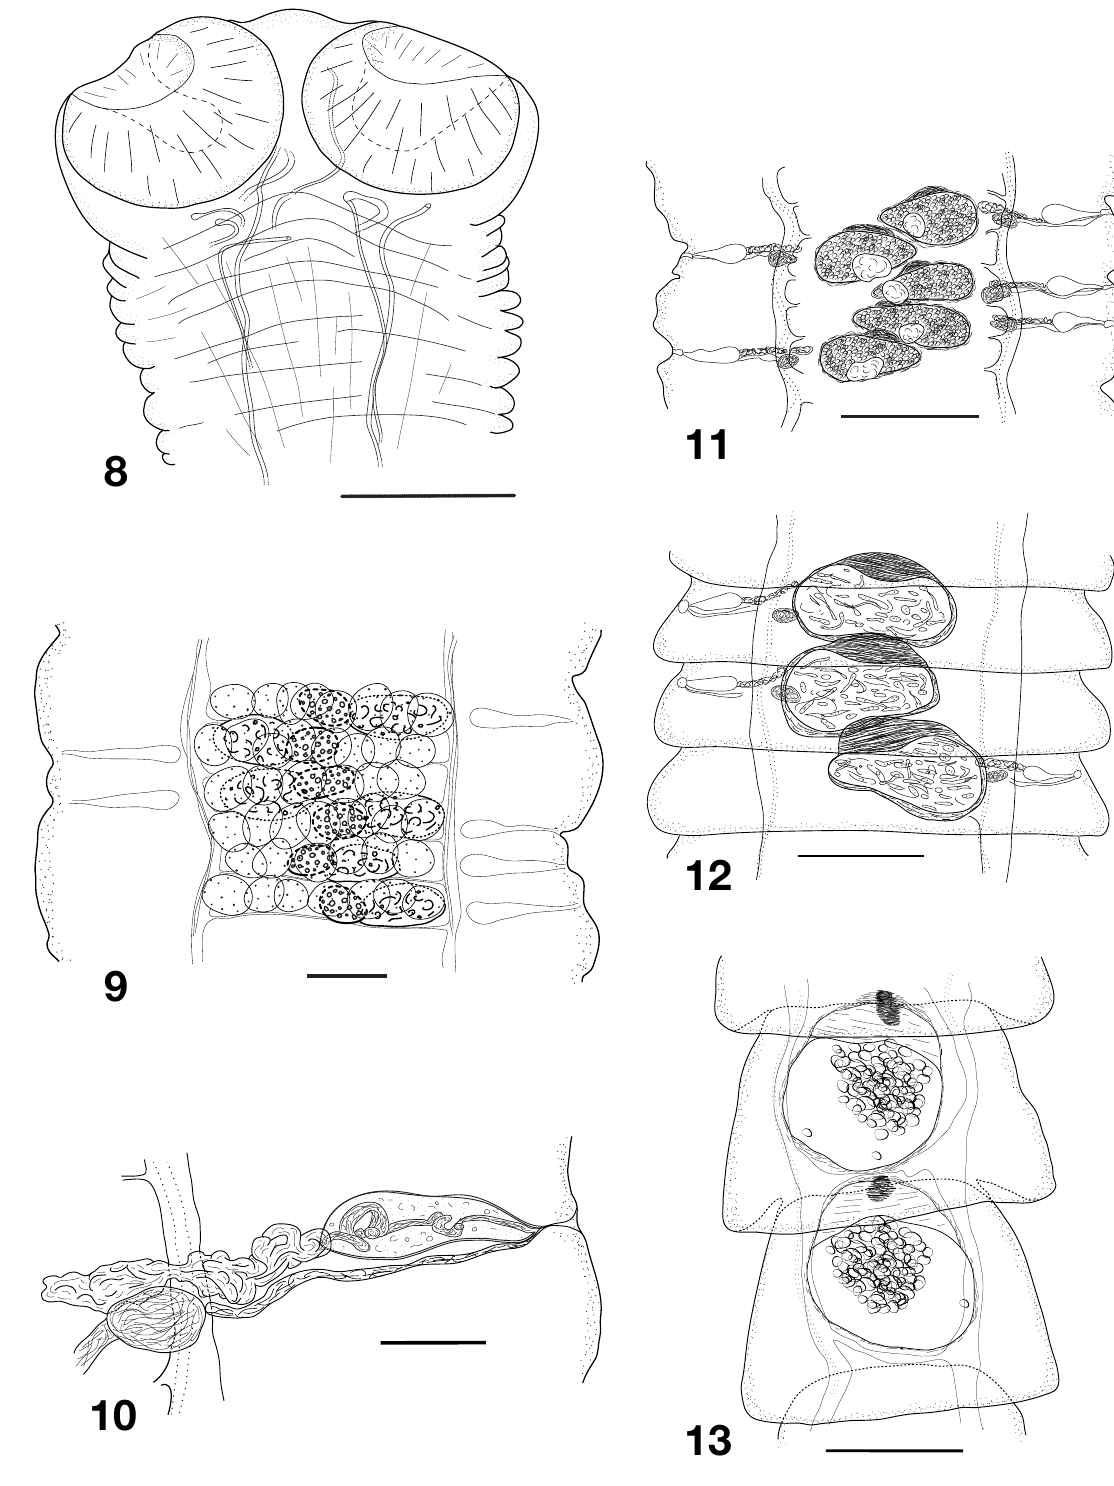
Figs 8–13. Anonchotaenia kornyushini sp. nov. 8 . Scolex. 9 . Mature proglottis. 10 . Cirrus-sac, dorsal Figs 8-13. Anonchotaenia kornyushini sp. nov. 8 . Scolex; 9 . Mature proglottis; 10 . Cirrus-sac, dorsal view; 11-13 . Various stages of uterine and paruterine organs development. Scale bars: 8, 9 = view. 11–13 . Various stages of uterine and paruterine organ development. Scale bars: 8–9 = 100 µm; 100µm; 10 = 50 µm; 11-13 = 250 µm. 10 = 50 µm; 11–13 = 250